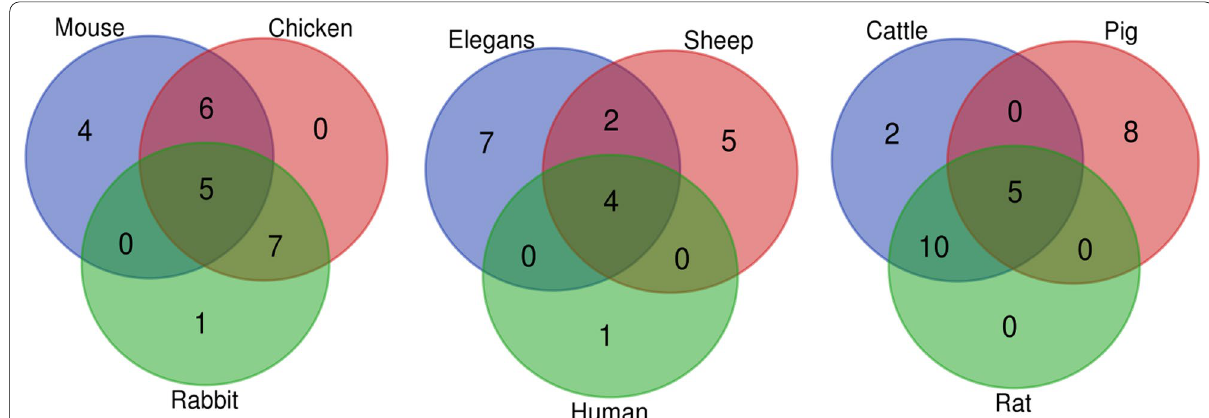
Fig. 4 Venn diagram showing unique genes and interaction similarities across the evolutionary diversity of HSP70 in the selected farm animals. A Comparison of the protein interaction of HSP70 in cattle, pig, and rat. B Comparison of the protein interaction of HSP70 in mouse, chicken, and rabbit C Comparison of the protein interaction of HSP70 in elegans, sheep, and